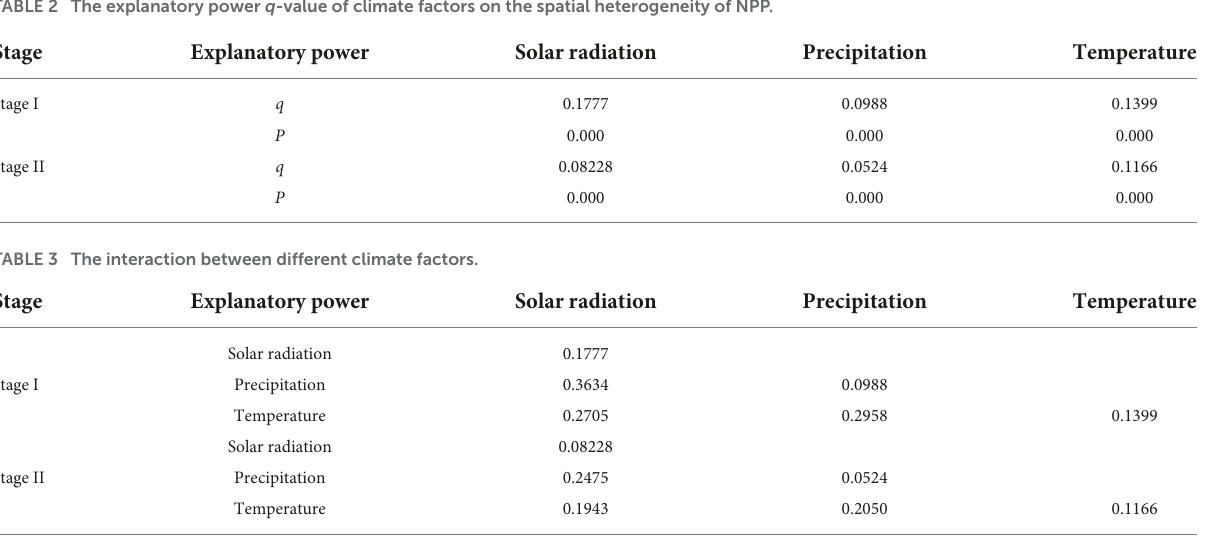
TABLE 2 The explanatory power q -value of climate factors on the spatial heterogeneity of NPP.